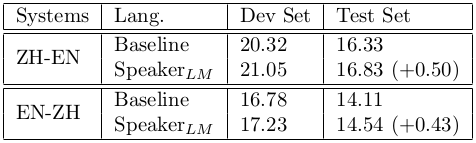
Table from the paper: Automatic Construction of Discourse Corpora for Dialogue Translation
Table text:
Systems
Lang.
DevSet
TestSet
ZH-EN
Baseline
20.32
16.33
Speaker LM
21.05
16.83(+0.50)
EN-ZH
Baseline
16.78
14.11
Speaker LM
17.23
14.54(+0.43)